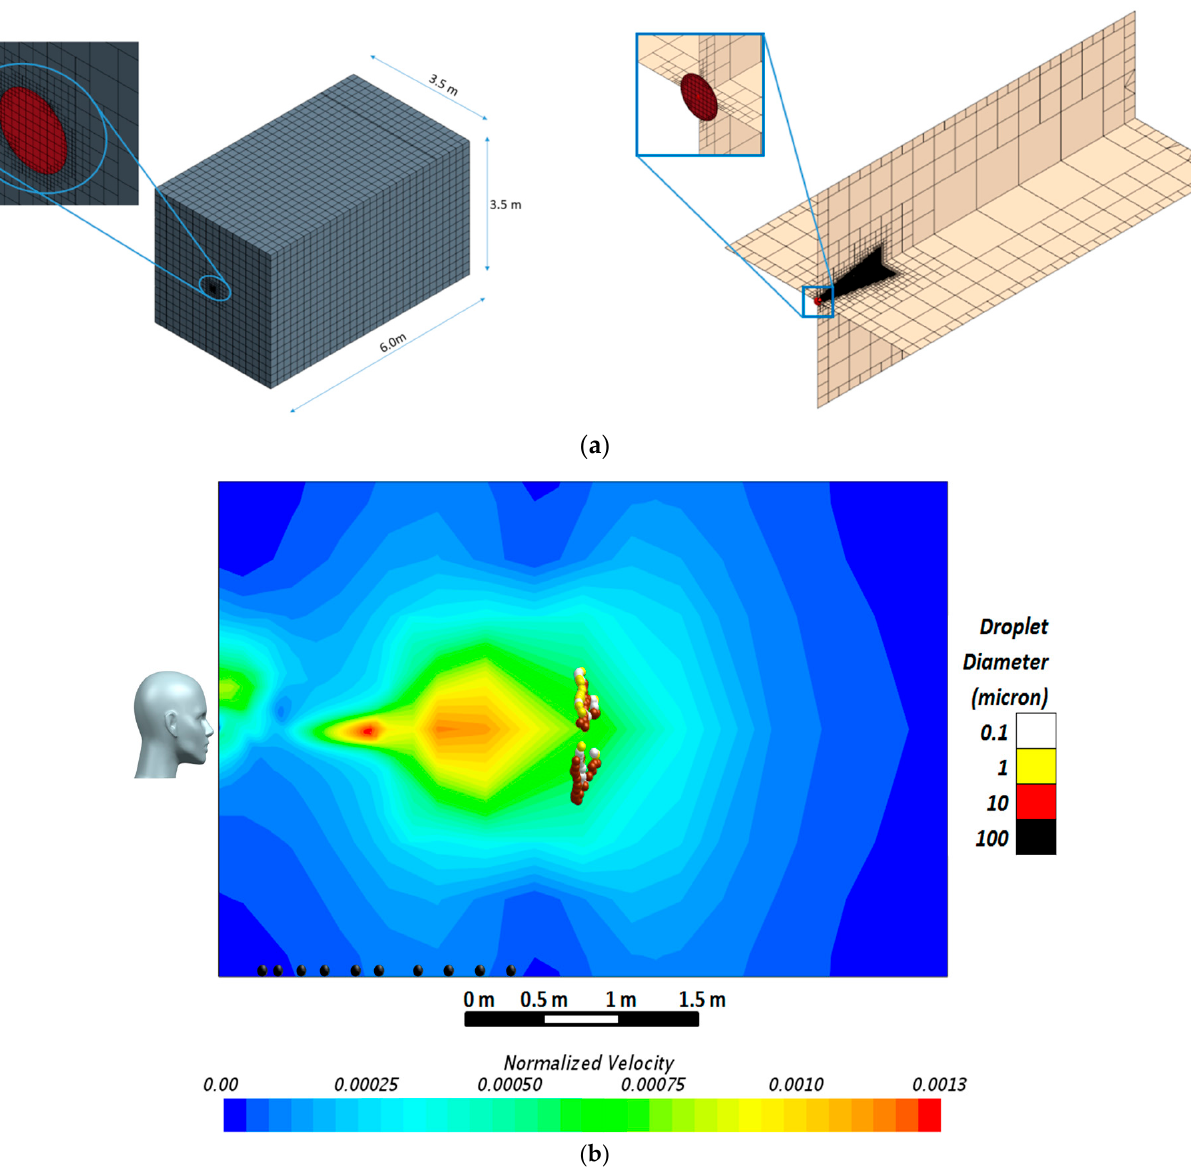
Figure 2. ( a ) Discretized computational domain with unstructured mesh and ( b ) velocity contours of the respiratory jet with a schematic of droplets. The color of droplets shows their size group.